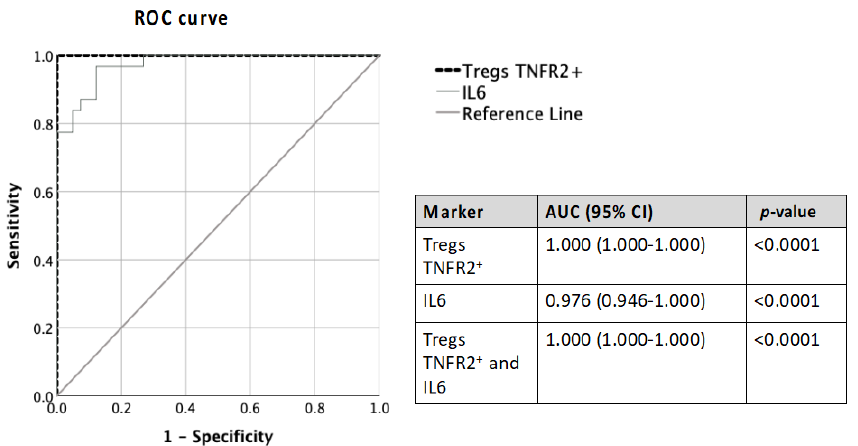
Figure 5. Comparison of ROC-AUC values of pre-treatment Tregs TNFR2 + and IL-6 alone and in combination in predicting ovarian